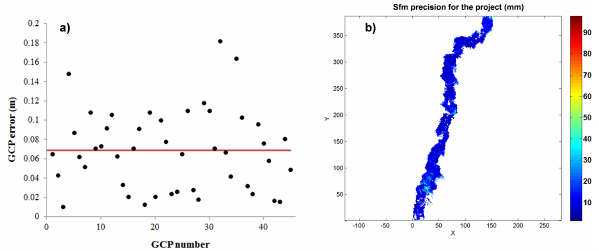
Figure 7. (a) Error magnitudes on the 3-D model (m) with dGPS ground control point measurements as the reference (the 0.069m average in red line); (b) estimated SfM local precision in mm (Eq. 1) taking into account the residuals in the image measurements and the camera-point distance for gully branch 1. The dominant dark blue colours show that average precision is around